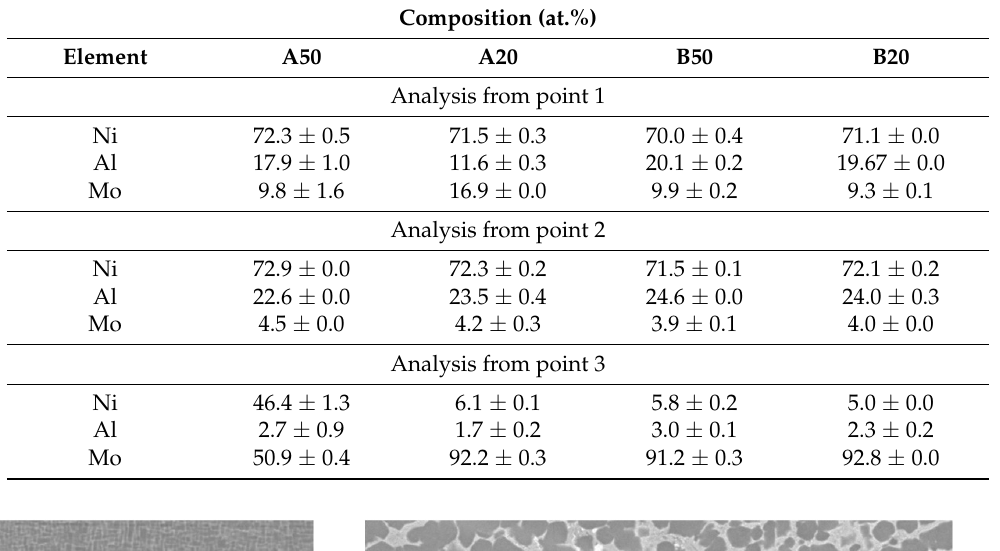
Table 2. The results of spot chemical analysis of Samples A and B. Composition (at.%)